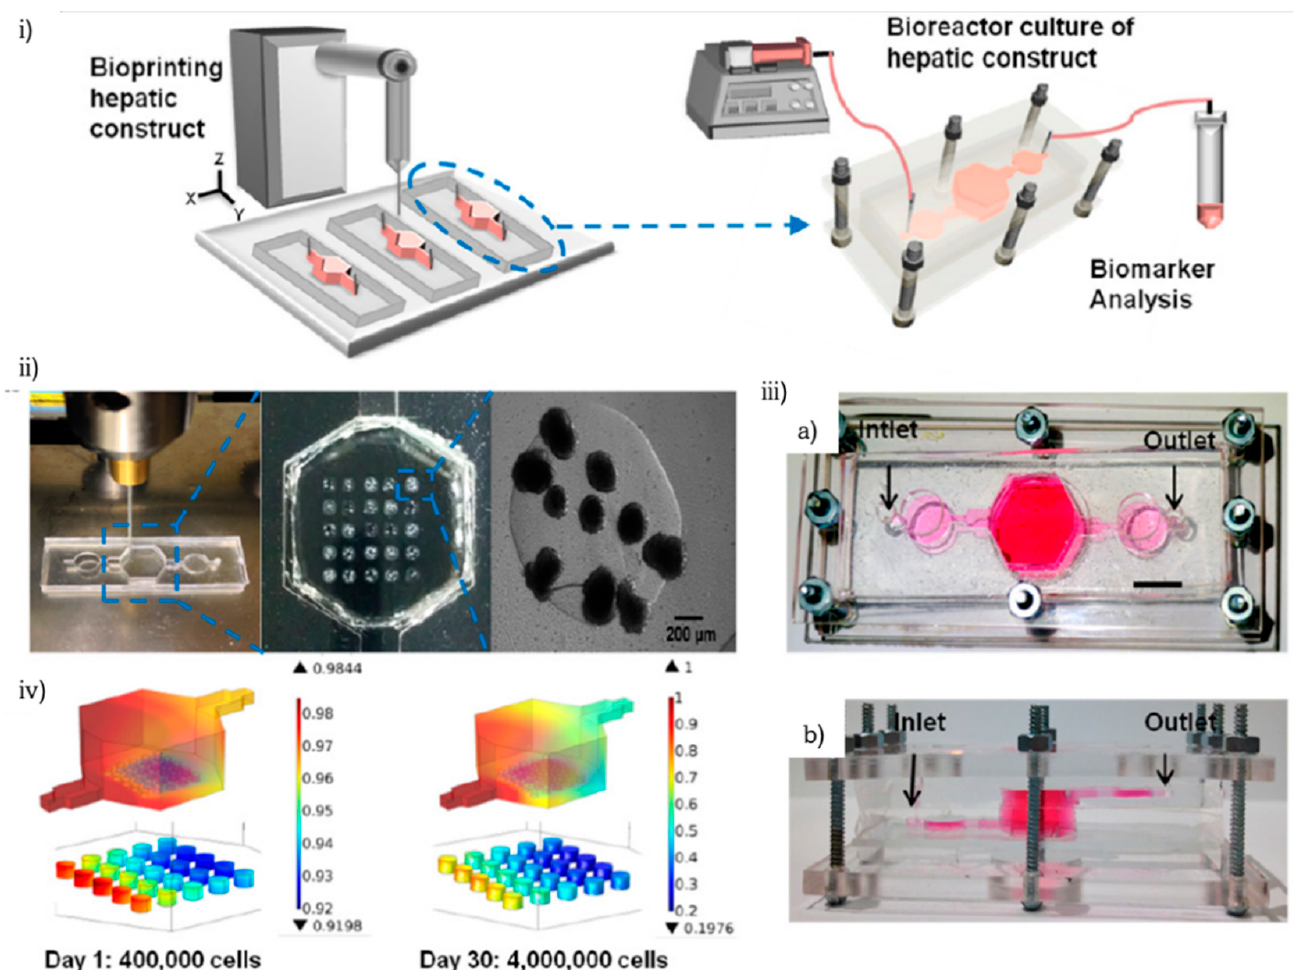
Figure 8. A liver-on-a-chip platform for long-term 3D culture of HepG2/C3A spheroids for drug toxicity assessment: ( i ) schematic of the hepatic bioreactor setup, ( ii ) bioprinting GelMA hydrogel- based hepatic construct within the bioreactor, ( iii ) (a) top and (b) side view of the bioreactor-chip assembly, ( iv ) oxygen concentration gradient. Reprinted with permission granted by Copyright Clearance Center, Inc. (“CCC”). Published in Biofabrication by IOP Publishing Ltd. Authors: N.S.